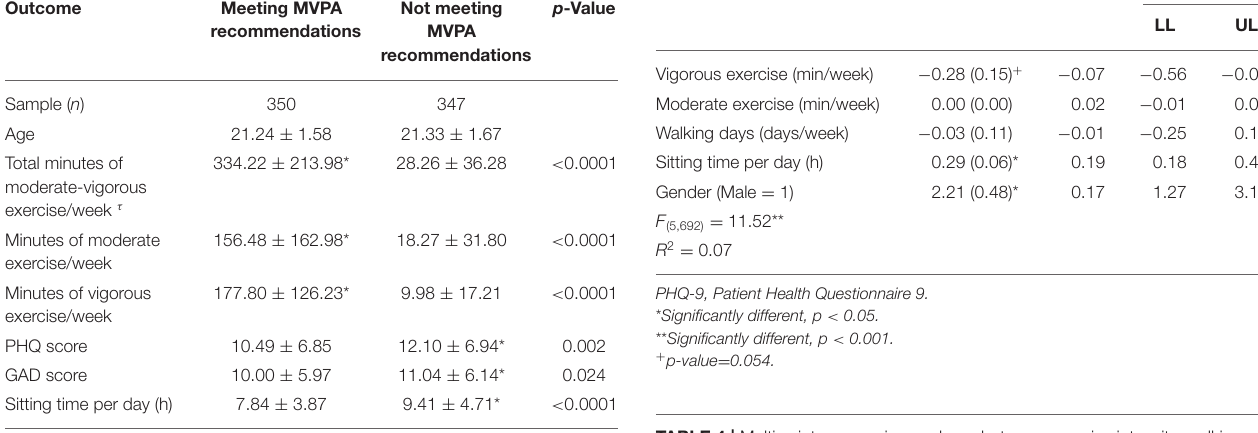
TABLE 4 | Multivariate regression analyses between exercise intensity, walking intensity, sitting times, and anxiety severity (based on GAD-7